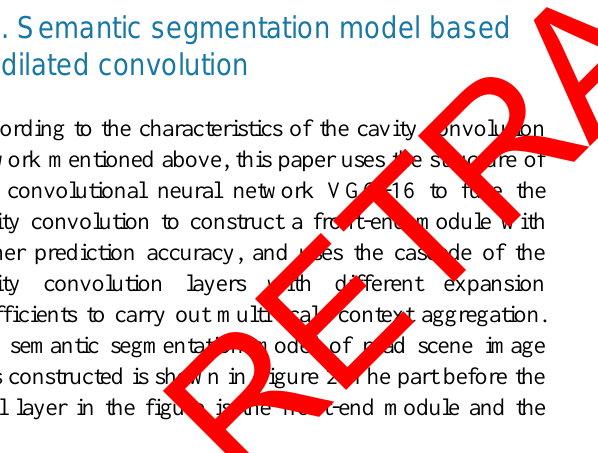
Table 1. Architecture parameters of context module